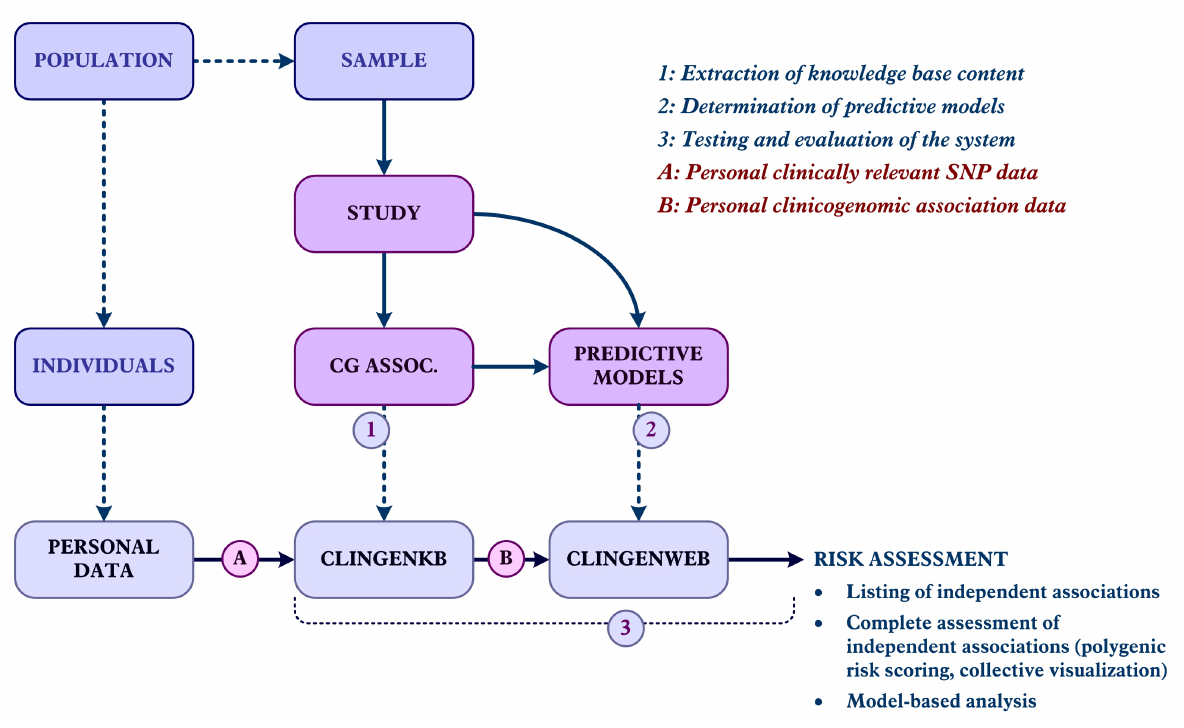
Main steps of the evaluation process. SNP=single nucletotide polymorphism; CG-ASSOC.=clinicogenomic